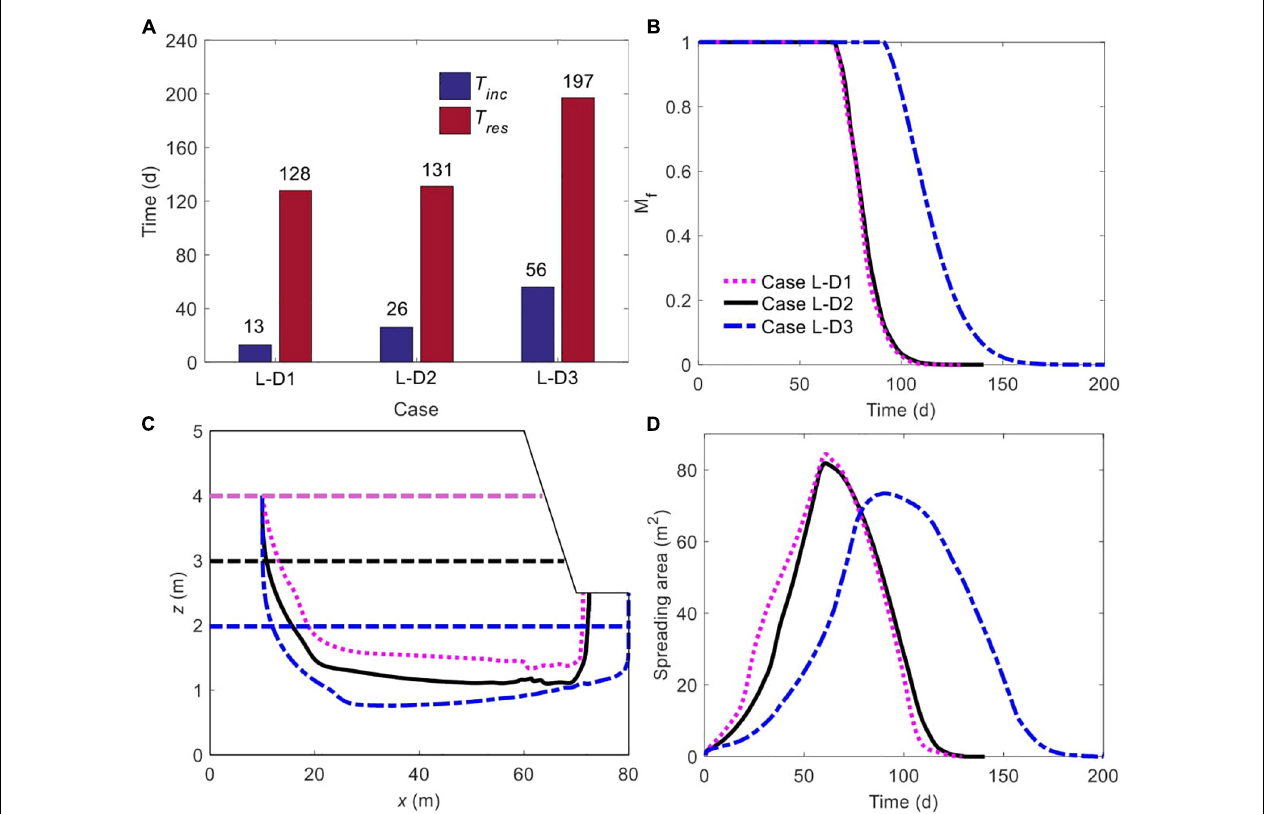
FIGURE 12 | Comparison of (A) initiation time of unstable flow and residence time of solute plume, (B) time-dependent, normalized amount of solute mass remaining in marsh soil, (C) spatiotemporal variation of plume centroid, and (D) plume spreading area for different D mud . The plume edge was determined based on the concentration of 0.0001 C 0 . The horizontal purple, black and blue dashed lines in panel (C) represent the boundary between mud layer (upper) and sand layer (deeper) in Cases L-D1, L-D2, and L-D3,